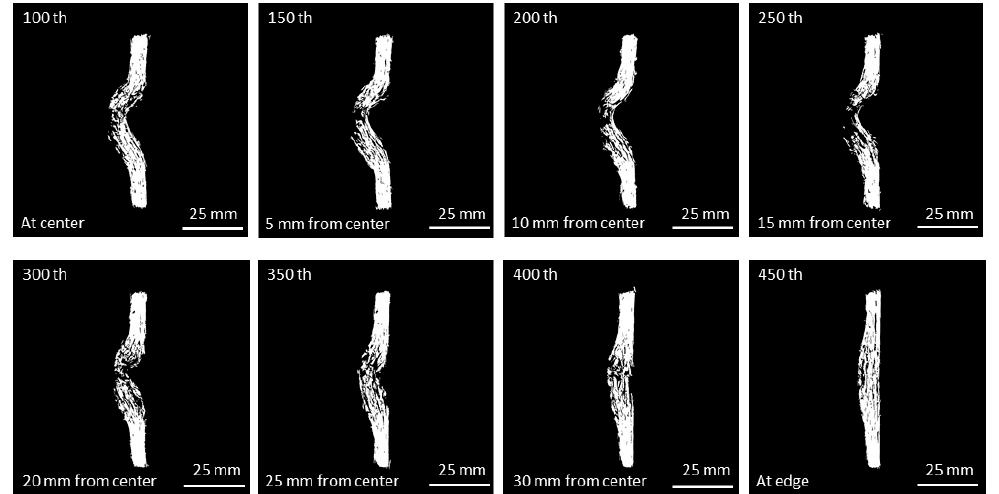
Figure 7. E-glass fiber composite after impact. µCT slices of damage from the center towards the edge. The fiber damage was investigated at the center and from each set of pictures, one picture was chosen at a distance of 5 mm towards the edge of the composite.